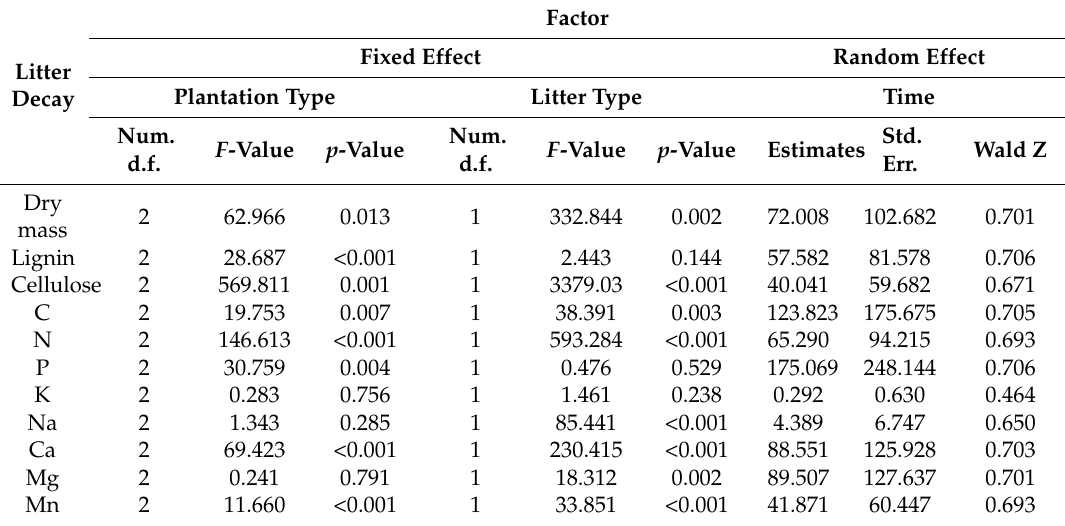
Table 4. Results of mixed effect model on litter decay (dry mass, organic chemical components, and nutrient elements) for the effects of sampling time, plantation type and litter